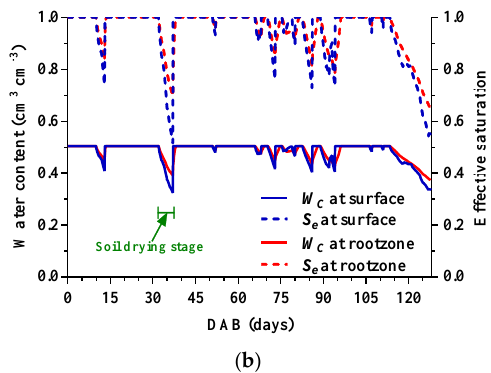
Figure 5. Simulated water contents ( W C ) and effective saturation ( S e ) at the soil surface and in the root zone during the 2008 ( a ) and 2009 ( b ) seasons.